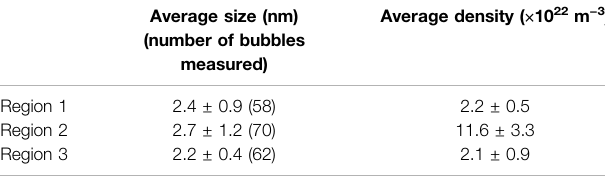
TABLE 2 | Summary of average size and density of bubbles in different regions.